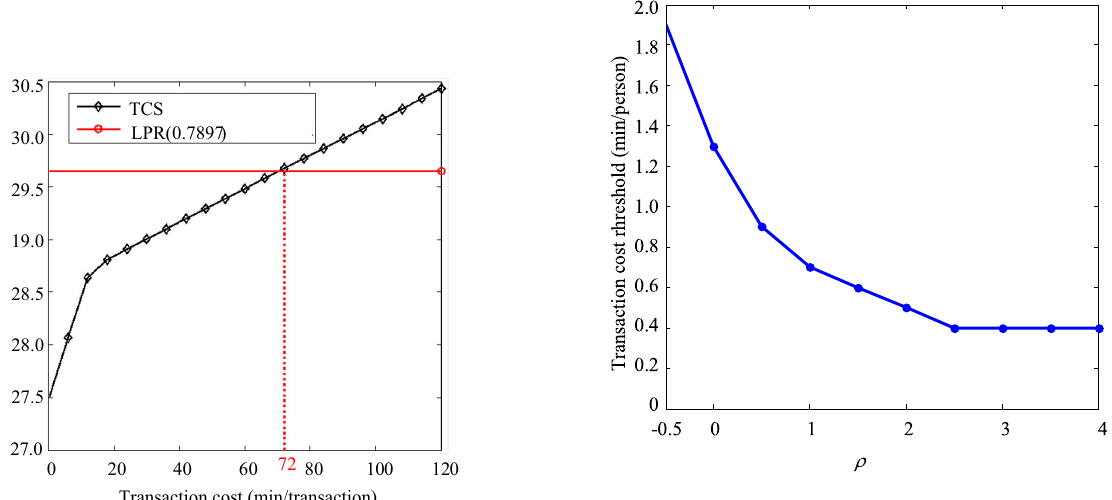
Fig. 4 G LPR changing with k